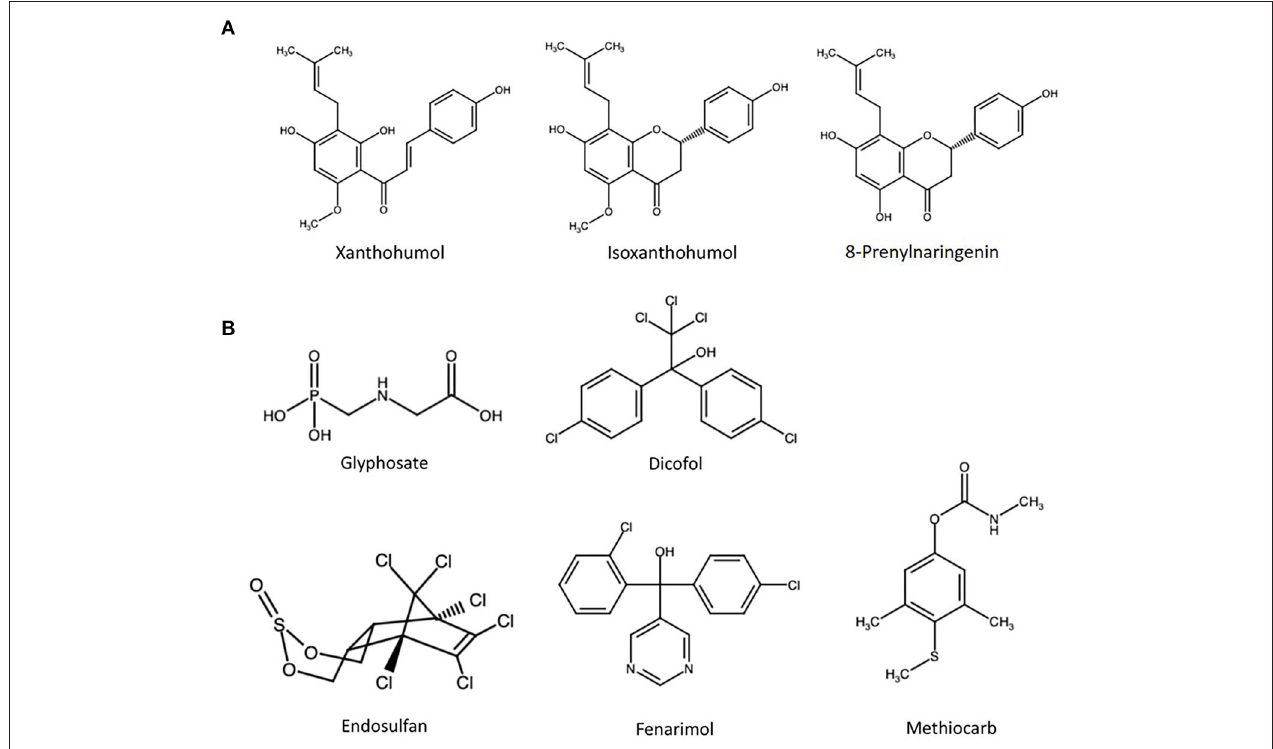
FIGURE 1 | Chemical structure of (A) the three most prevalent hop polyphenols in beer and (B) selected pesticides with at least one report of